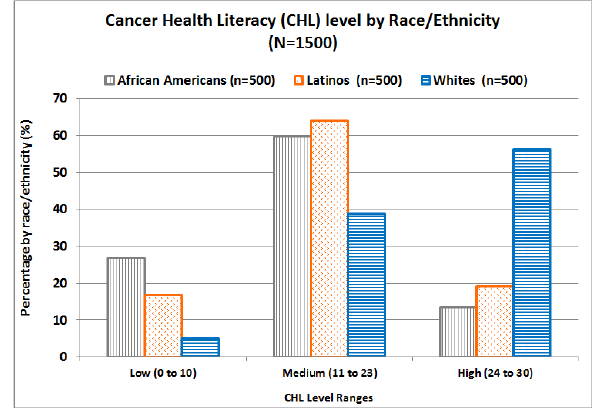
Figure 3. Cancer health literacy levels by race/ethnicity.